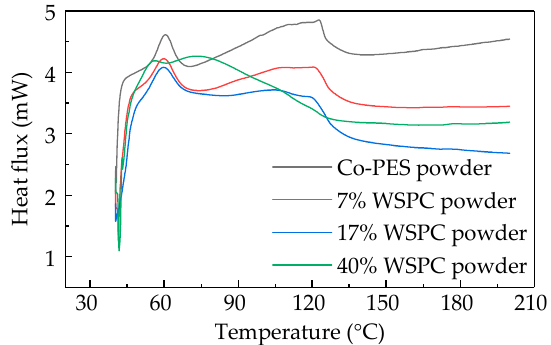
Figure 4. Differential scanning calorimeter (DSC) curves of the WSPC powder with different ingredient proportions.